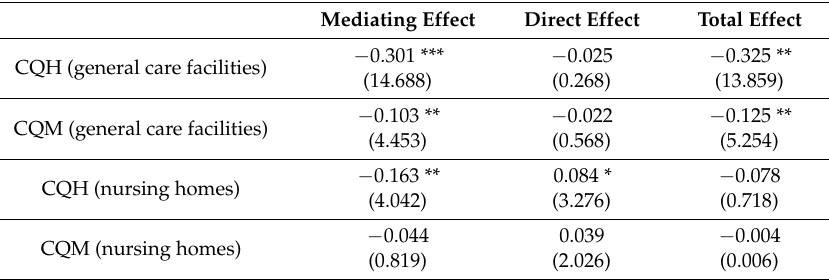
Table 12. Impact of quality of care on MTE